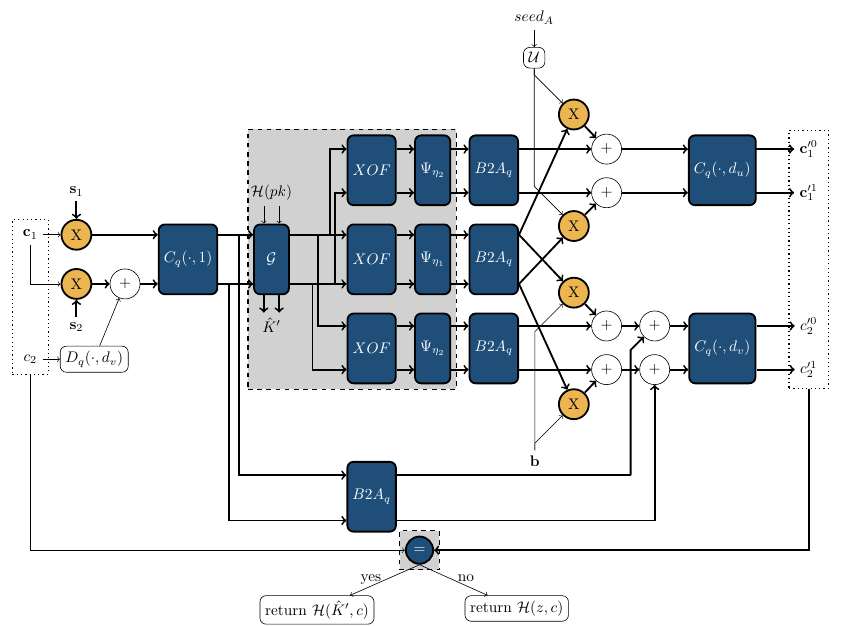
Figure 2: Masked decapsulation of Kyber. Linear performance bottlenecks highlighted in yellow, non-linear masked routines highlighted in blue, operations that require Boolean masking grouped in light